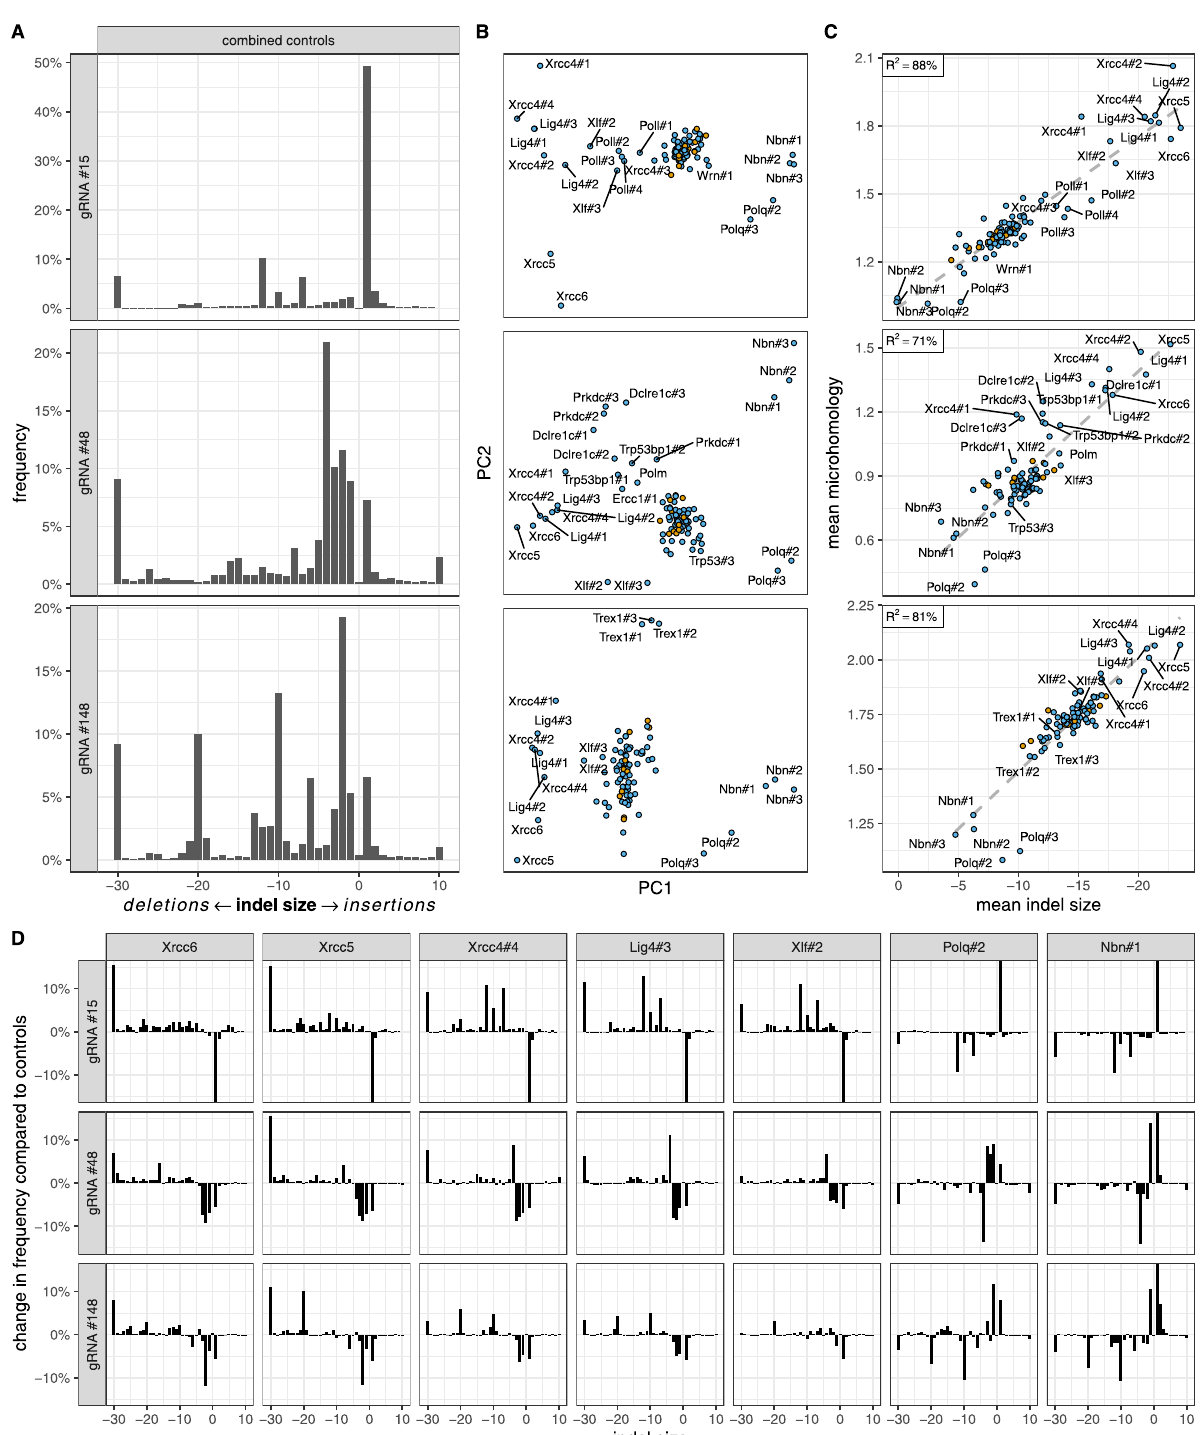
Fig. 2 Core end joining genes in fl uence indel pro fi les globally. A Indel pro fi les in combined 12 control samples. B Relationships between cell clones based on their indel pro fi les. Clones signi fi cantly different from controls in both replicates are labeled (FDR-corrected p < 0.01 from a chi-squared distribution, see Methods). The arrangement of non-signi fi cant clones is in Supplementary Fig. 3C. C Correlation between mean indel size and microhomology. D Relative frequencies of indel sizes compared to controls in de fi cient clones with a signi fi cant impact on all three gRNAs. Indel pro fi les of other clones with signi fi cant impact are in Supplementary Fig. 6. Y axis is truncated at − 15% and + 15%. In panels ( A ) and ( D ), indel frequencies are aggregated by combined size. Negative numbers represent deletions and positive ones represent insertions. The leftmost and rightmost bars ( − 30 and 10) combine all larger deletions and insertions, respectively. Biological replicates ( N = 2) were averaged for clarity. All rows in panels ( B ) and ( C ) relate to the same gRNAs as in panel ( A ). In panels ( B ) and ( C ), controls are in orange and samples are in